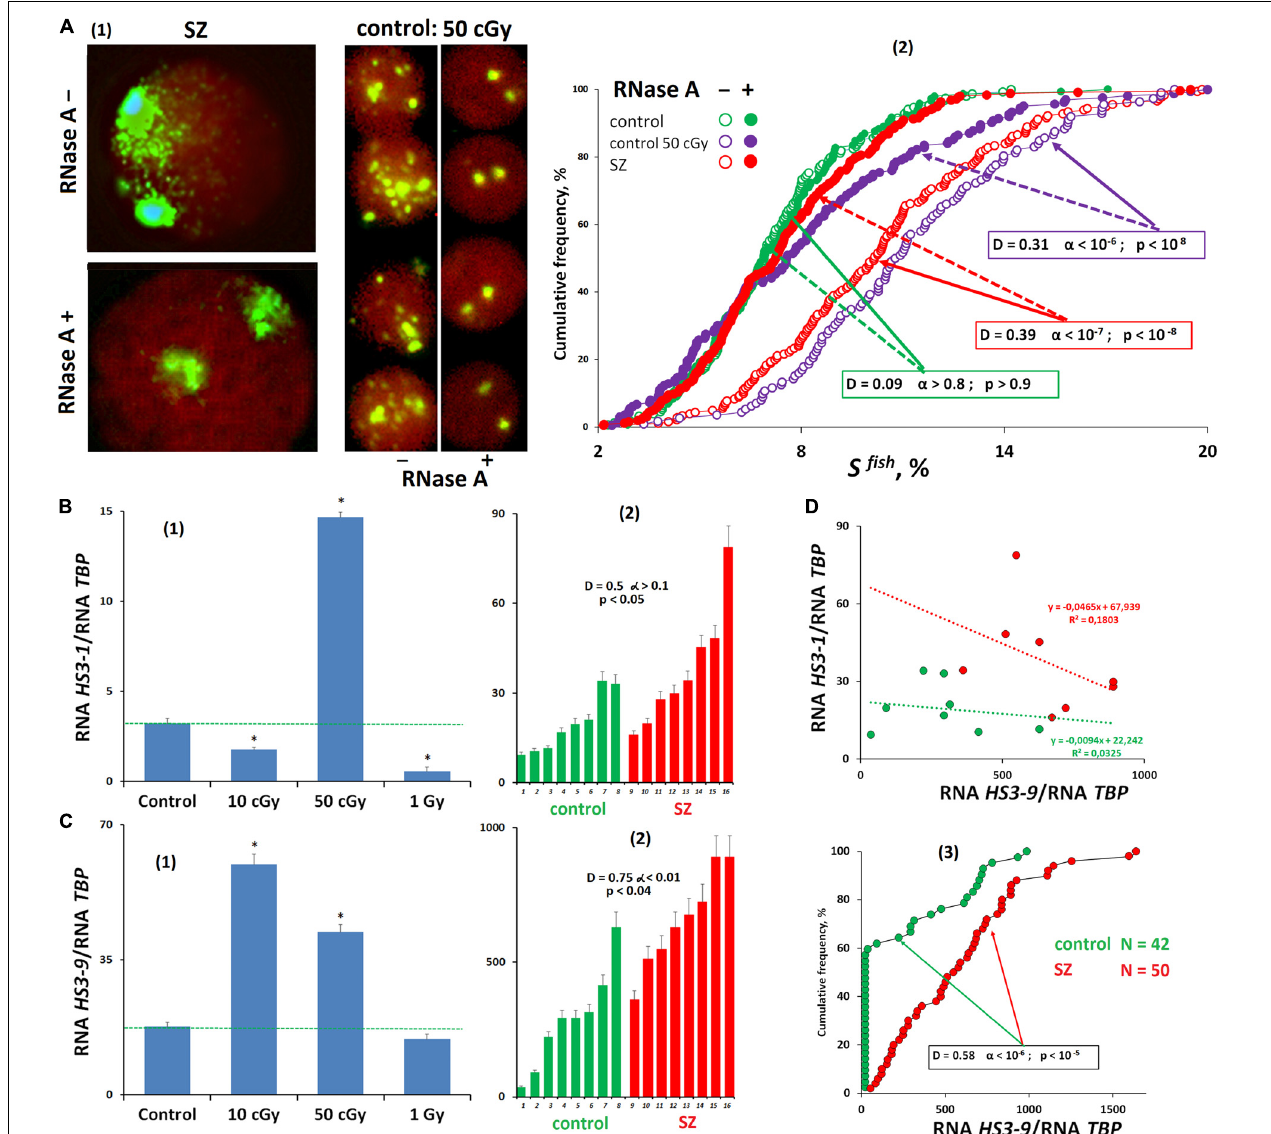
FIGURE 3 | Transcription of satellite III in human cells. (A) Processing the nuclei with RNase A reduces the FISH-signal area. (1) Examples of the nuclei of SZ patients and nuclei of irradiated HC cells treated and untreated with RNase A before the FISH. (2) Cumulative histograms of the frequency distribution of the FISH signals by the square S FISH for treated and untreated with RNase A intact HC, irradiated HC (50 cGy, 48 h), and SZ lymphocytes. (B) Transcription of f-SatIII DNA (HS3-1). (1) Irradiated lymphocytes (72 h after exposure). (2) White blood cells of SZ and HC groups. (C) Transcription of satellite III located on chromosome 9 (HS3-9). (1) Irradiated lymphocytes (72 h after exposure). (2,3) White blood cells of SZ and HC groups. (D) Dependence of the amount of RNA HS3-1 on the amount of RNA HS3-9 for two